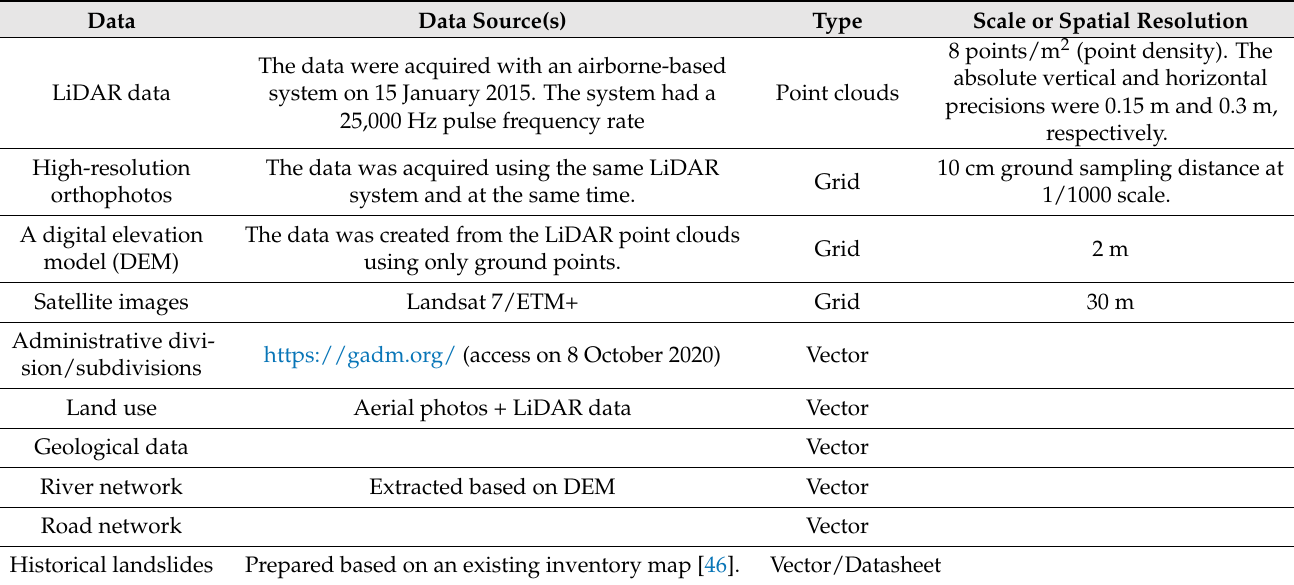
Table 1. List of datasets used to model landslide susceptibility at the study area.